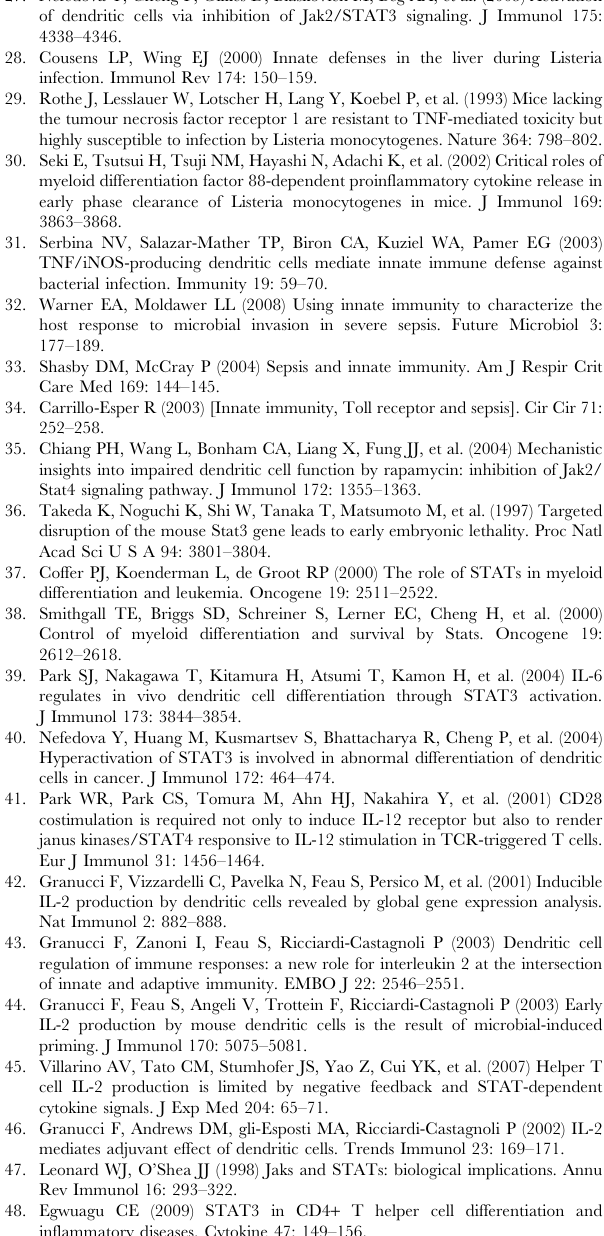
Figure S6 Flow cytometry analysis of apoptotic BMDCs and splenic DCs after LPS challenge (A) BMDC apoptosis after LPS stimulation. BMDCs were stimulated 10 m g/ml LPS for 96 h and then stained with Annexin-V and PI followed by flow cytometry analysis of apoptotic cells. (B) Splenic DC apoptosis after LPS challenge. Jak2 2 / 2 and control mice were first challenged with 150 m g/mouse of LPS and were sacrificed after 20 h of injection. Splenic DC apoptosis was then analyzed by flow cytometry as above.